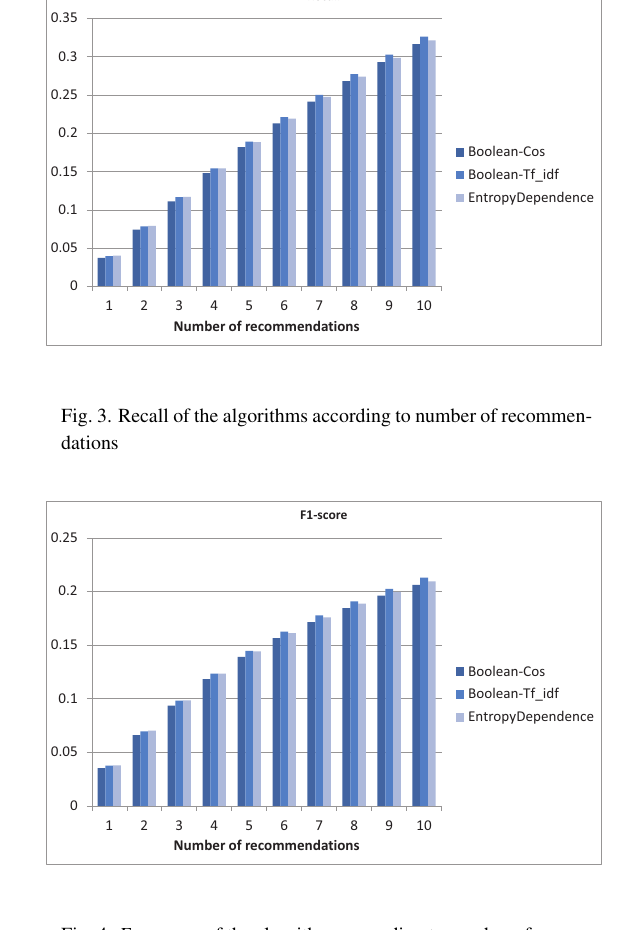
Fig. 4. F 1 − score of the algorithms according to number of recom-